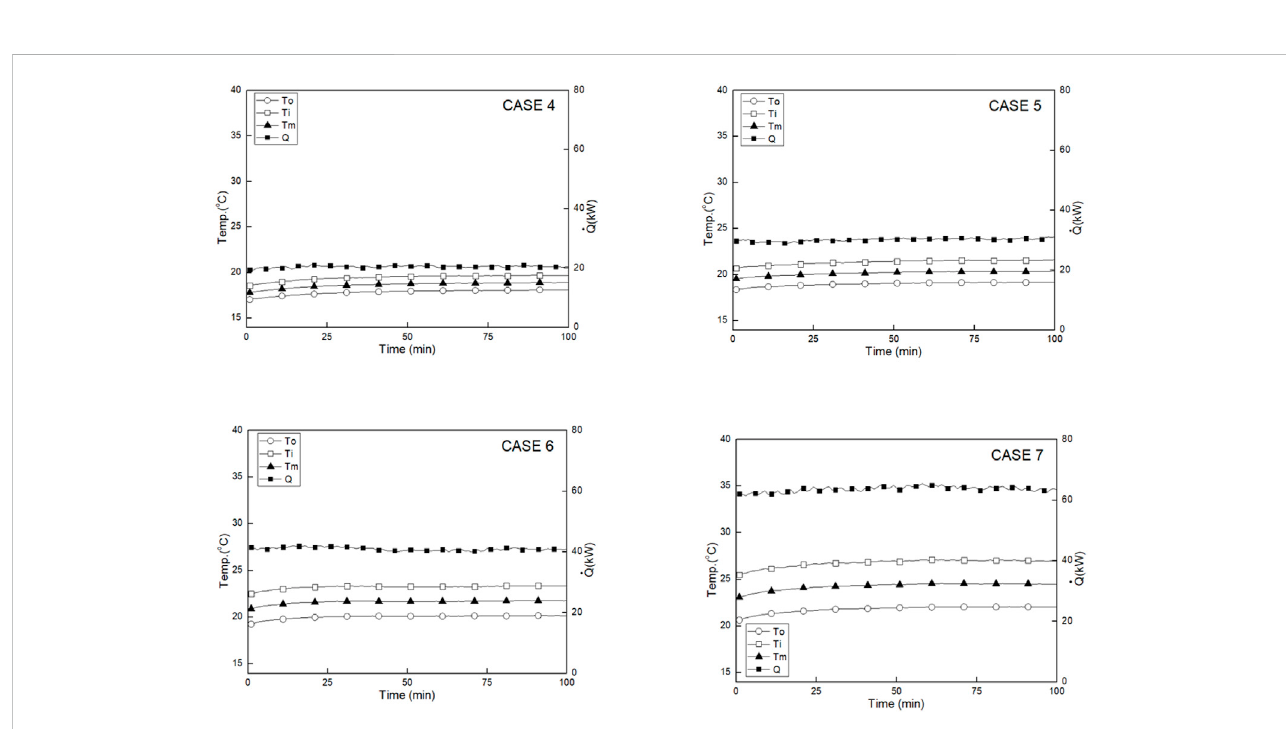
FIGURE 4 Variation of the T i , T o , T m and power consumption (STS